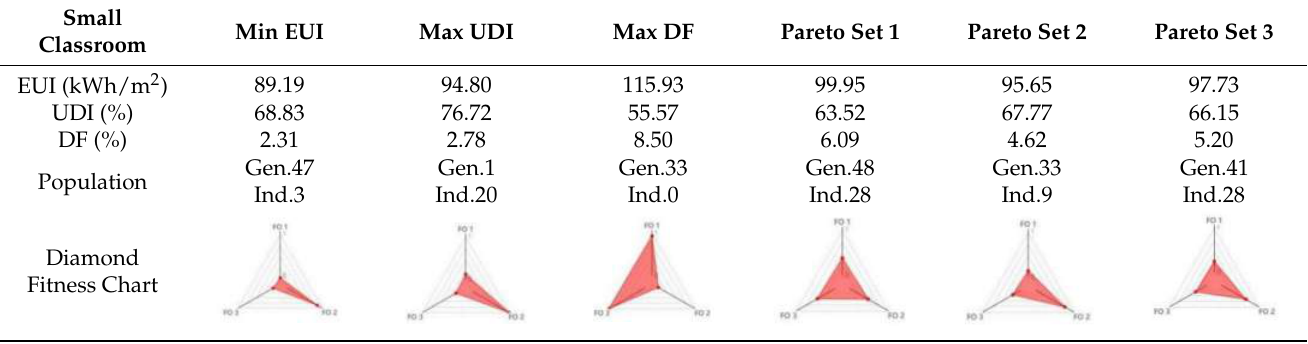
Table 9. The case of small-sized classrooms with window openings on the east facade.